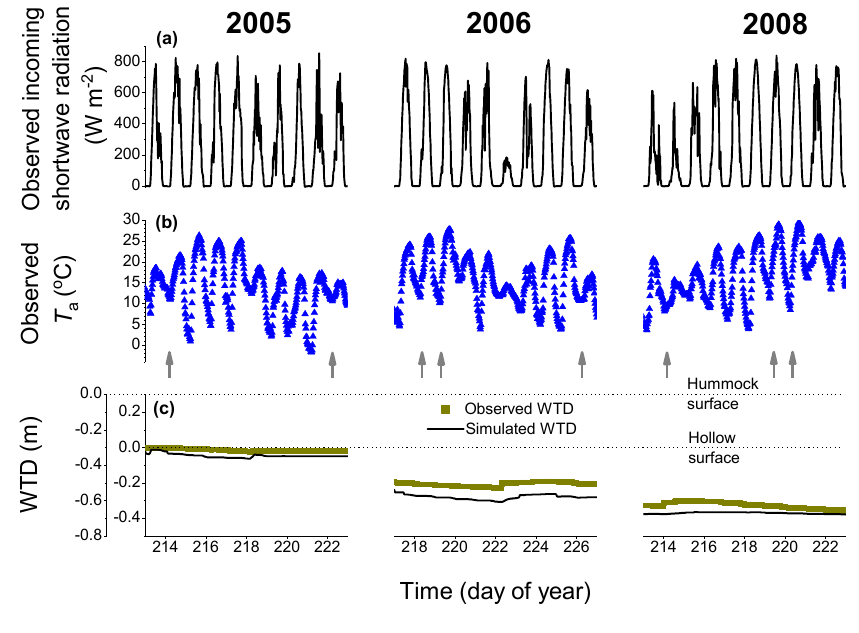
Figure 4. Half-hourly measured (a) incoming shortwave radiation and (b) T a and (c) hourly modeled and half-hourly measured (Syed et al., 2006; Cai et al.; 2010, Long et al.; 2010, Flanagan and Syed, 2011) WTD during August of 2005, 2006 and 2008 at a western Canadian fen peatland. A negative WTD represents a depth below hummock/hollow surface, and a positive WTD represents a depth above hummock/hollow surface. Grey arrows indicate nights with similar